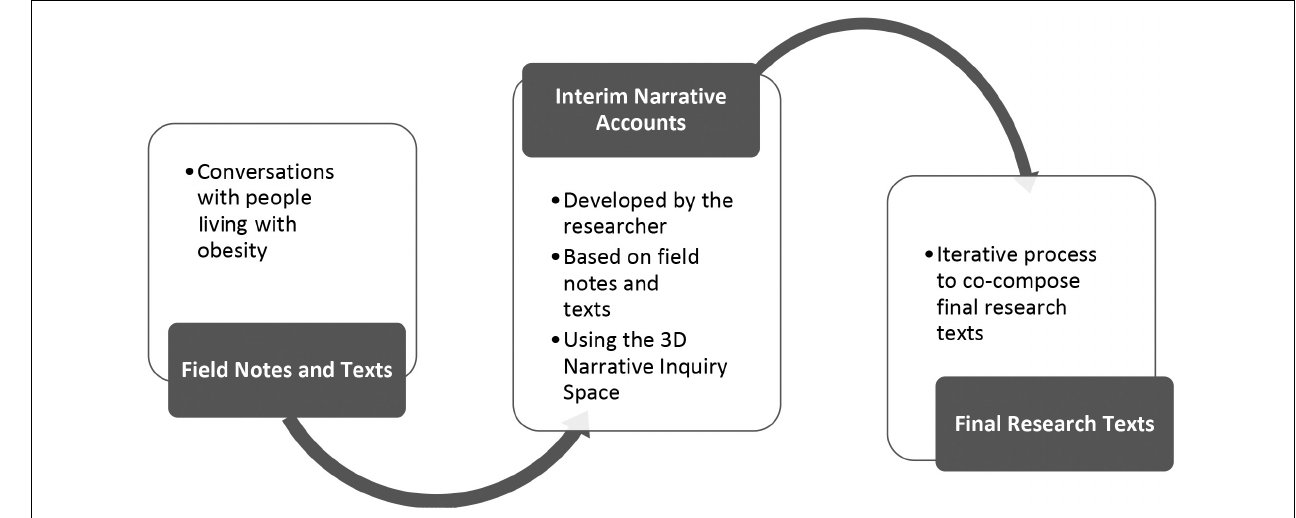
FIGURE 1 | Narrative inquiry